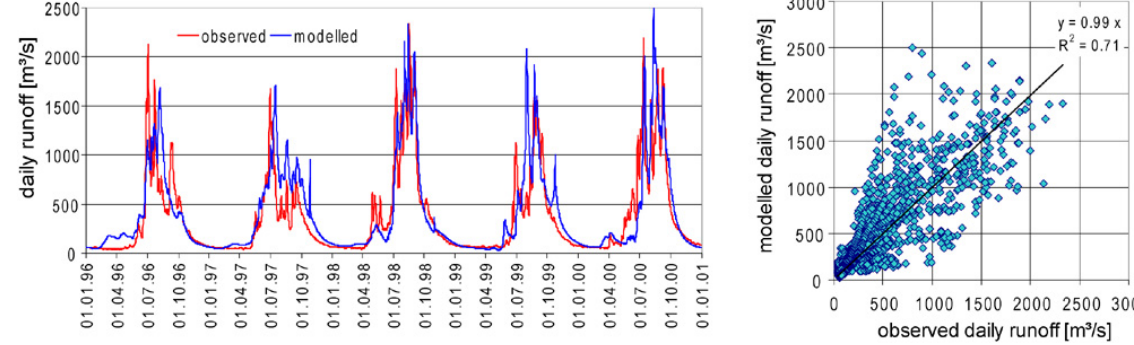
Figure 8. Modelled (CLM ERA driven) and observed monthly runo ff at the gauge in Lhasa at the Lhasa River for 1996–2000.